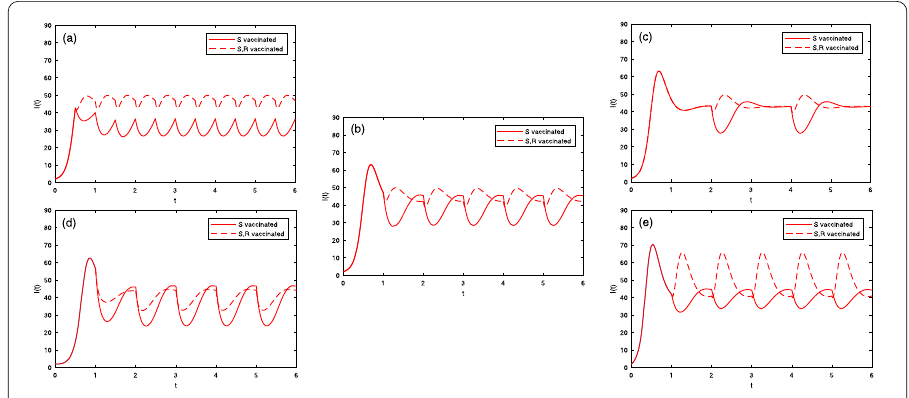
Figure 4 ( a )–( c ) The number of infectious swines according to time when vaccination occurs at the beginning of each time interval semiannually, annually, and biennially for q = 0.5, u = 0 for two vaccination scenarios, (A) and (B). In ( d ) and ( e ), vaccination occurs annually but the vaccination coverage is set to be 0.7 and 0.3, respectively